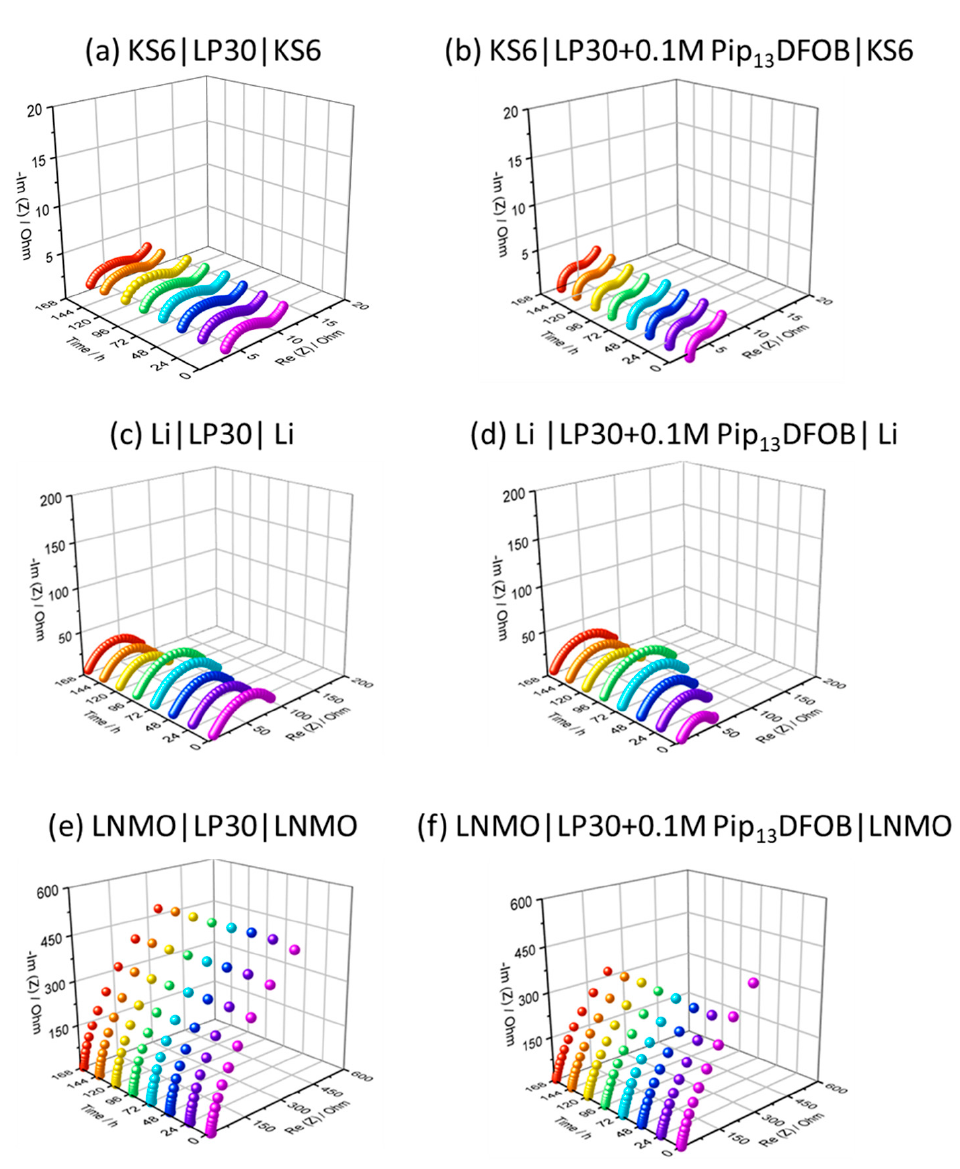
Figure 5. Nyquist plots of KS6|KS6 ( a , b ), Li|Li ( c , d ), and LNMO|LNMO ( e , f ) symmetric cells with LP30 ( a , c , e ) and 0.1M Pip 13 DFOB solution ( b,d , f ).